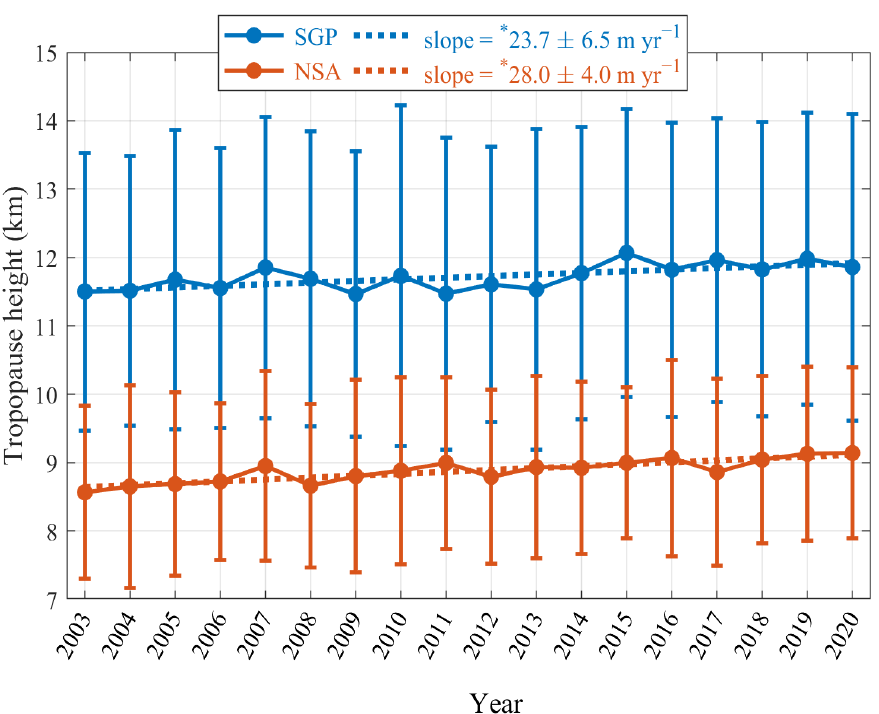
Figure 10. Annual variability and its standard deviation in the radiosonde observed tropopause height at SGP (solid blue line) and NSA (solid brown line); the dashed lines denote the linear regressions of the tropopause heights at the two sites, with the linear slope and its uncertainty noted in the legend (* marks significance at p -value < 0.05).